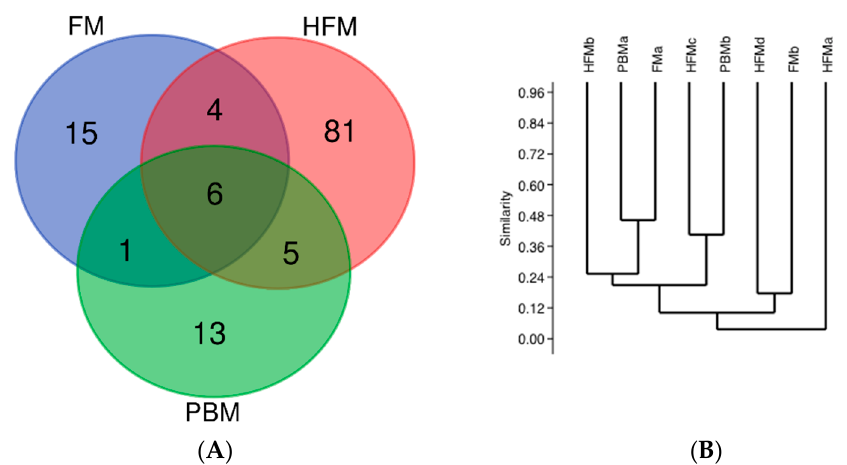
Figure 5. ( A ) Venn diagram showing shared and unique OTUs between the dietary groups (FM,